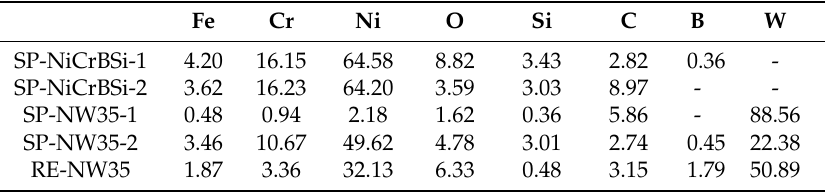
Table 4. Chemical Compositions of Debris as Marked in Figure 7